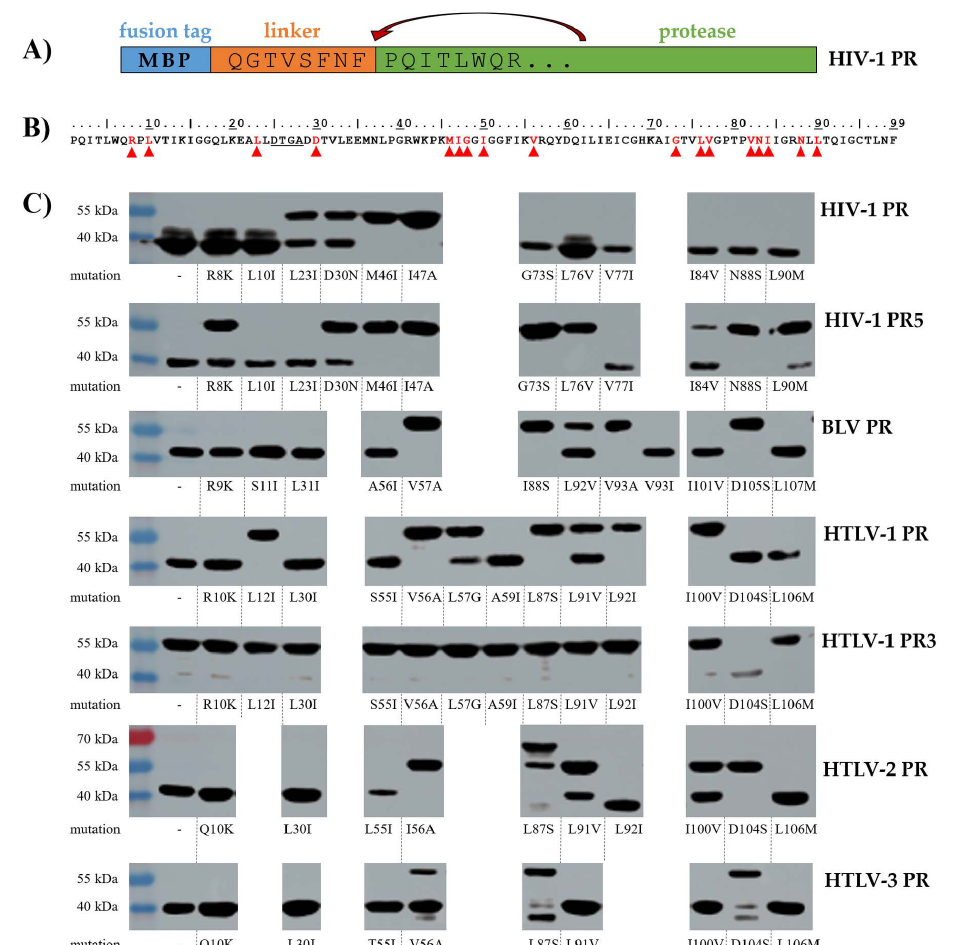
Figure 3. Autoproteolysis of MBP-fused proteases. The proteases were expressed as MBP-fusion proteins, the short linker between the tag and the enzyme represented P8-P1 residues of the natural N-terminal autoproteolytic cleavage site of the protease as exemplified by the wild-type HIV-1 PR ( A ). The effects of protease mutations on the self-processing capability are summarized in Table 2, the studied positions are red and are shown in the sequence of HIV-1 PR by arrowheads ( B ). Rep- resentative Western blots are shown based on at least three independent experiments. Anti-MBP antibody was used for Western blot. The bands at higher and lower molecular weights correspond to the full-length MBP-fused proteins and the MBP released via self-processing, respectively ( C